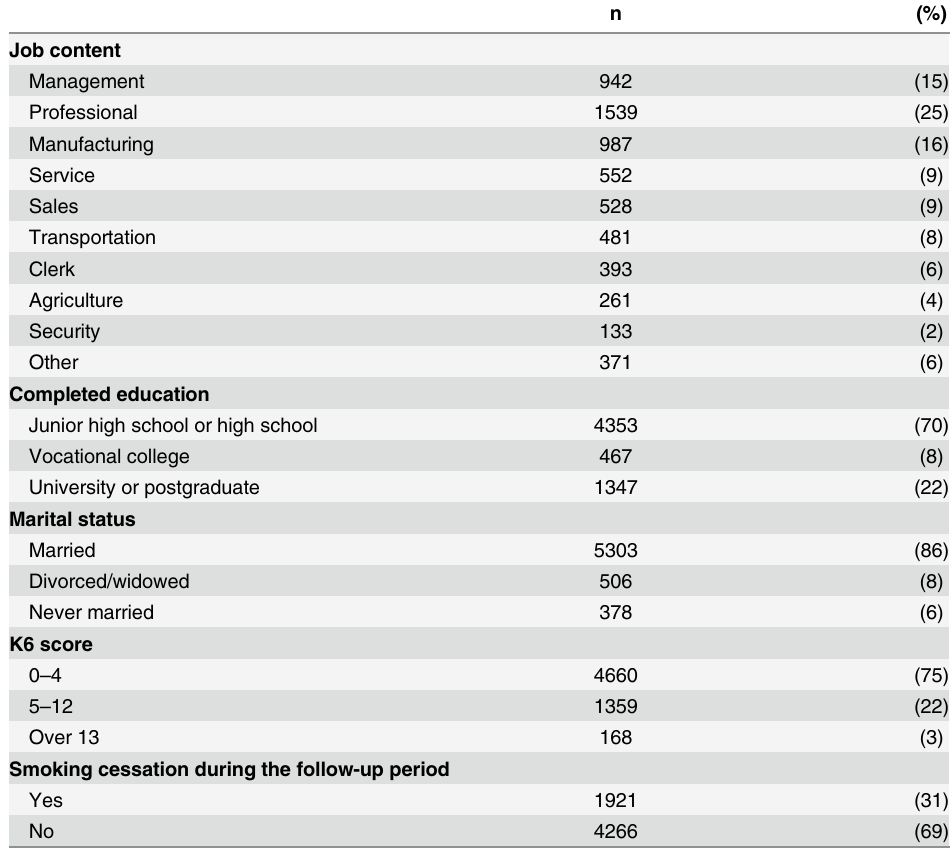
Table 1. Participant characteristics at baseline (n = 6187).